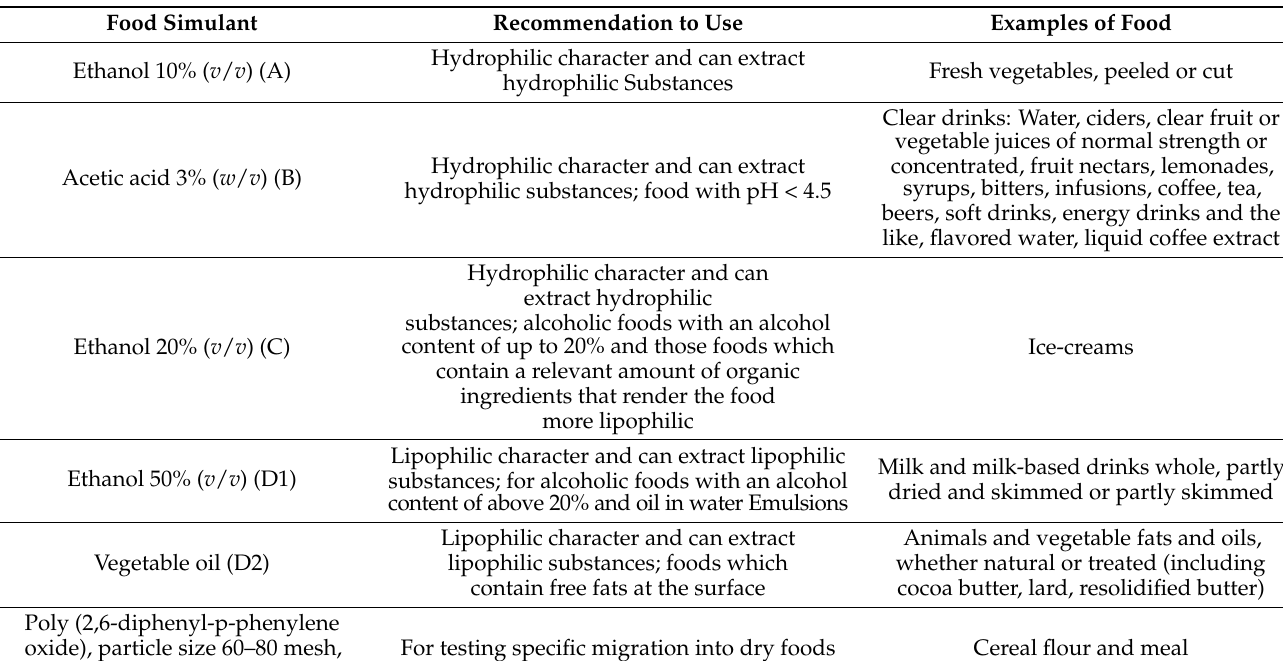
Table 7. Food simulants recommended by the (EU) n ◦ 10/2011 and examples of applications. Food Simulant Recommendation to Use Examples of